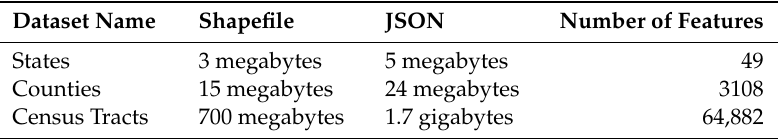
Table 2. Vector dataset